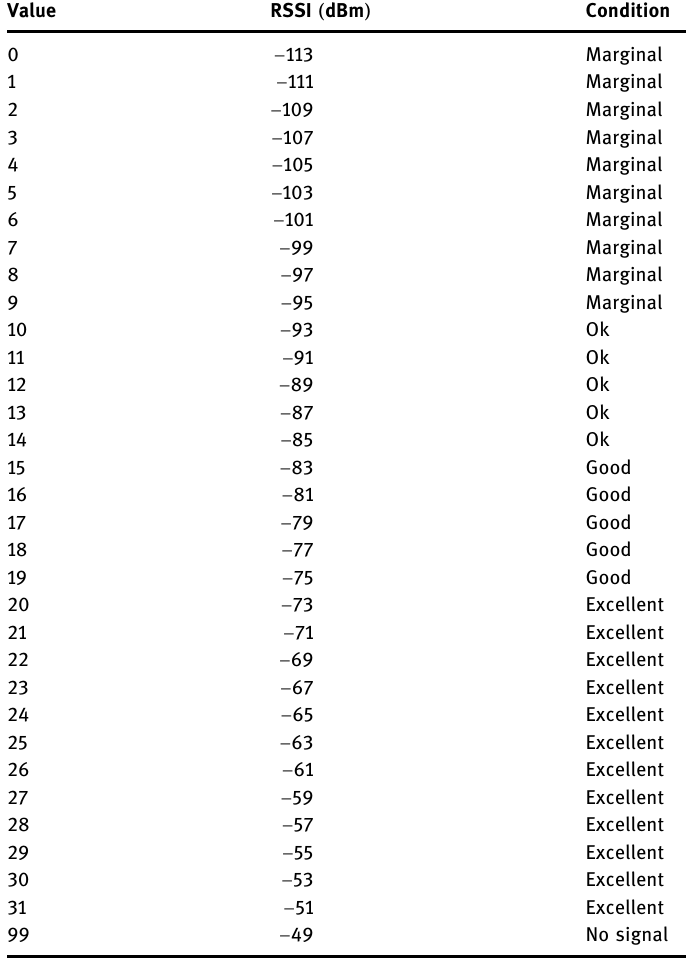
Table 1: Values of RSSI before applying the proposed algorithm